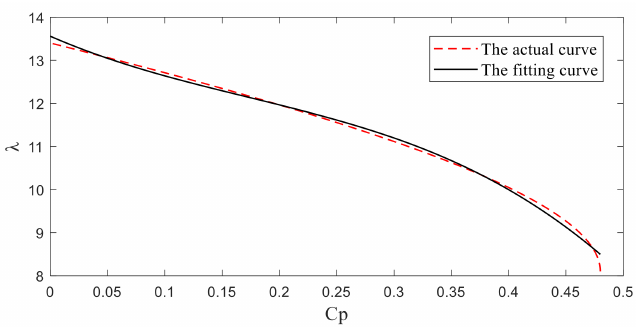
Figure 4. Actual curve and fitting curve of λ